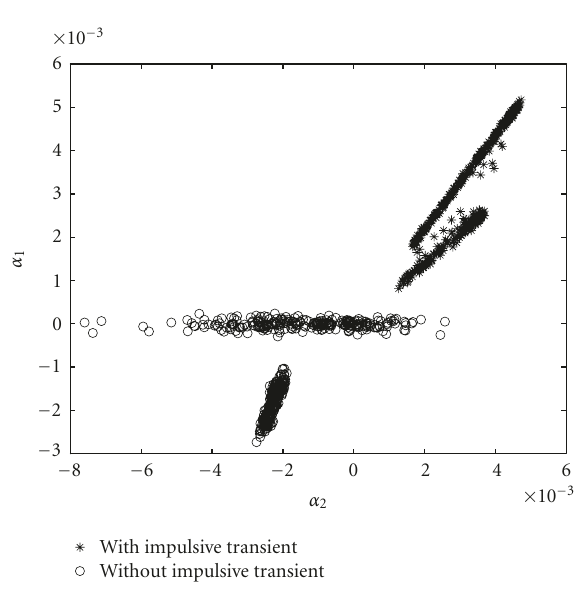
Figure 23: HOS-based features extracted from u to classify the im- pulsive transient α 1 = (cid:21) c 2, u (4) and α 2 = (cid:9) c 2, u